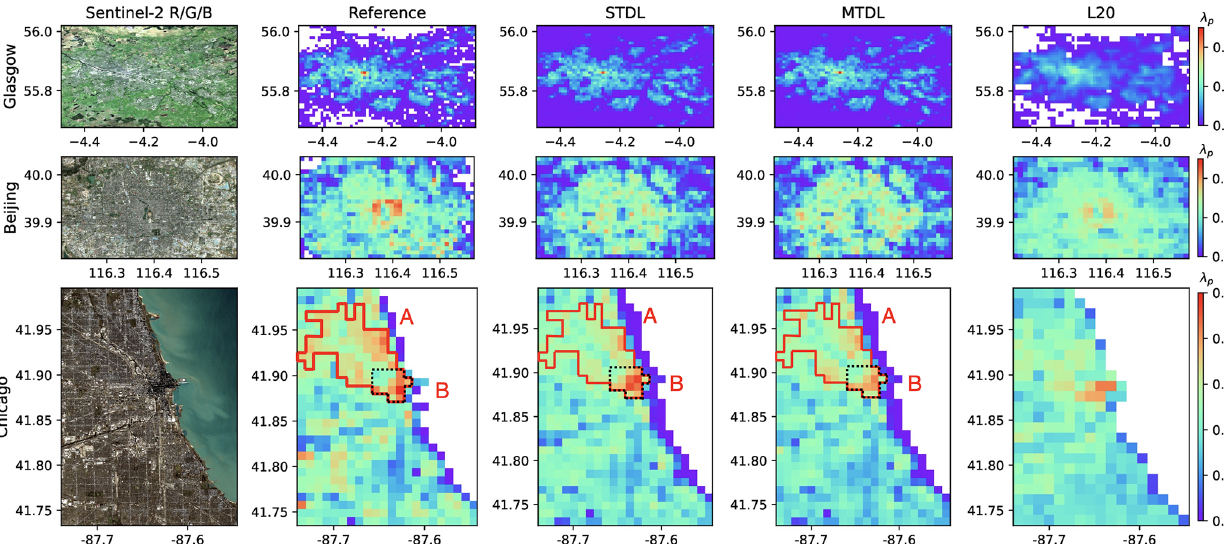
Figure 15. Same as Fig. 14, but for building footprint. In Chicago, high-density built-up areas and surrounding areas of peak values are outlined by red lines and dotted black lines, respectively, where area A is determined based on the connected component analysis on the map of pixels with an average building footprint value higher than 0.3 and area B contains pixels with λ p > 0 .